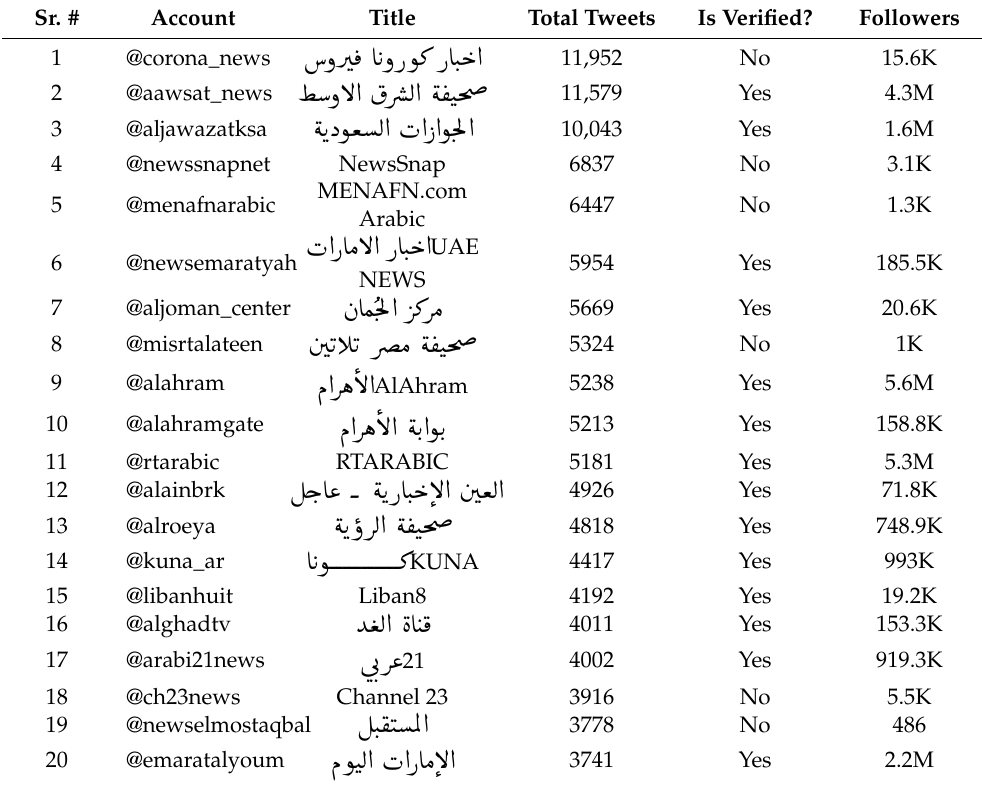
Table 2. Top 20 users in our